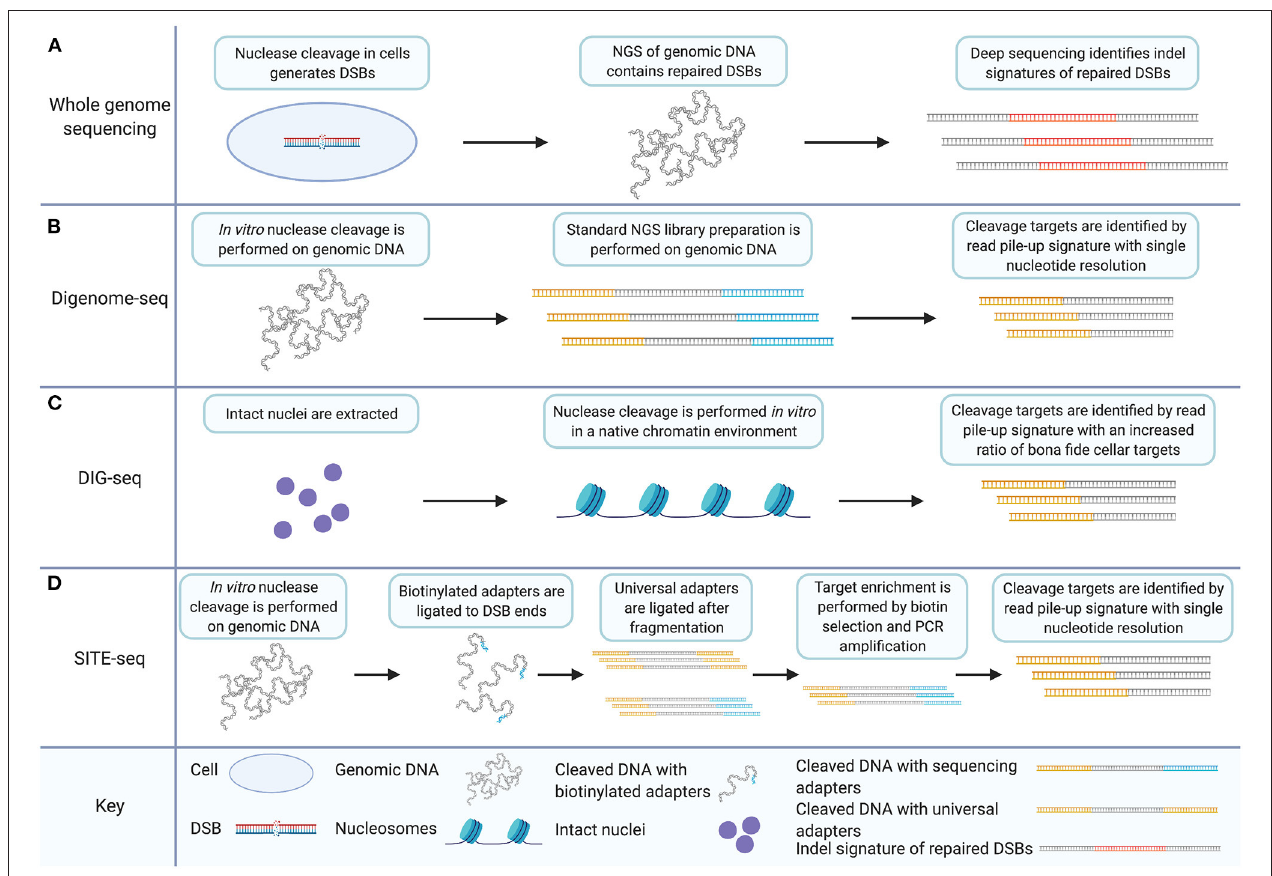
FIGURE 1 | In vitro off-target detection methods based on WGS utilize target enrichment strategies that facilitate data analysis and improve signal to noise ratios. (A) WGS for CRISPR/Cas9 off-target detection involves nuclease induction of DSBs in cells. Deep sequencing of genomic DNA captures all sequence including indels and genomic rearrangements introduced during DSB repair. (B) Digenome-seq involves extraction of genomic DNA and in vitro CRISPR/Cas9 treatment which precludes DSB repair. Samples are prepared by standard NGS methods where adapters (in yellow) are added. Cleavage targets are identified by a read pile-up signature with single-nucleotide resolution. (C) DIG-seq involves nuclei extraction. Nuclease cleavage is carried out in vitro in the native chromatin environment and libraries are prepared for NGS. Cleavage targets are identified by read pile-up, as in standard Digenome-seq. Intact chromatin reduces false discovery and increases the ratio of bona fide cellular targets identified. (D) SITE-Seq involves in vitro Cas9 digestion, as in Digenome-seq and DIG-seq. Biotinylated adapters (in blue) are then ligated to DSB ends followed by fragmentation and universal adapter ligation. Target enrichment is achieved by biotin selection and PCR amplification. As